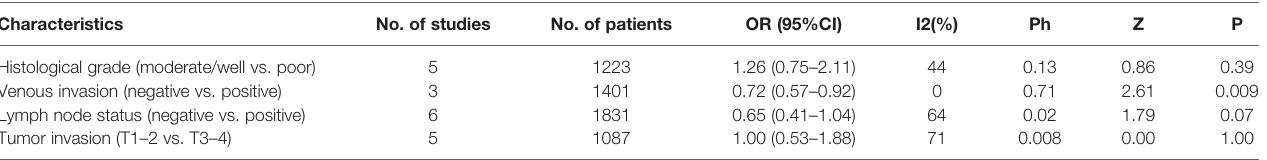
TABLE 3 | Meta-analysis of TSR and clinical-pathological characteristics in RC patients.